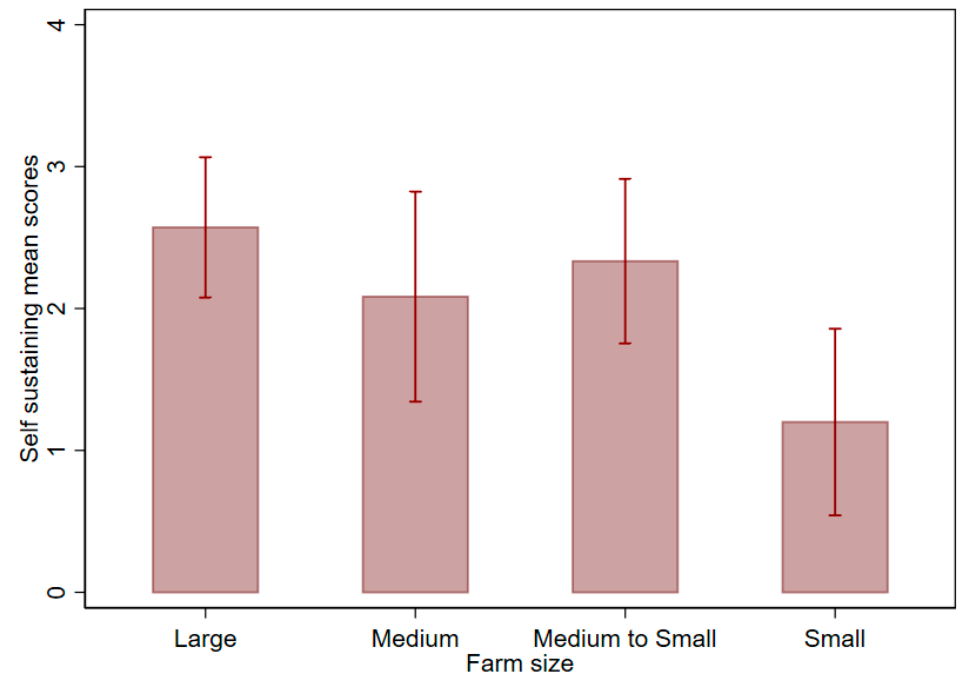
Figure 2. Mean self-sustaining index by firm size (self-sustaining index: 0 = model no longer functional or requires 100% subsidy; 1 = mostly from public subsidy; 2 = mostly from sales; 3 = 100% self-sufficient). Firm size (based on number of employees). Note: error bars = standard errors (for Figures 2–4, the truncated axes start at zero for the ease of interpretation).